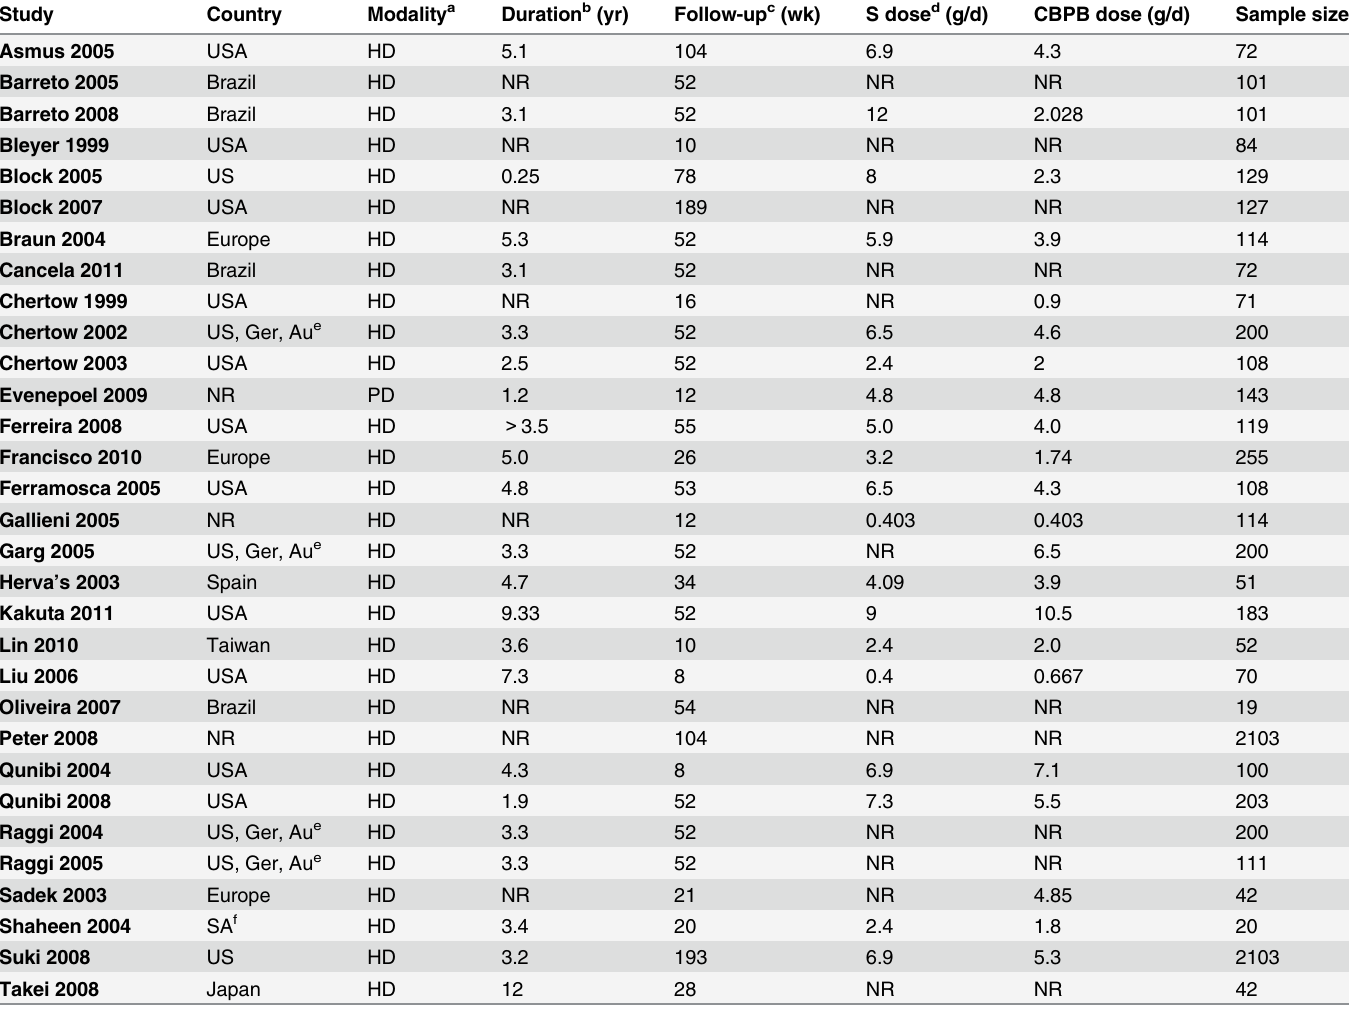
Table 1. Detailed characteristics of the